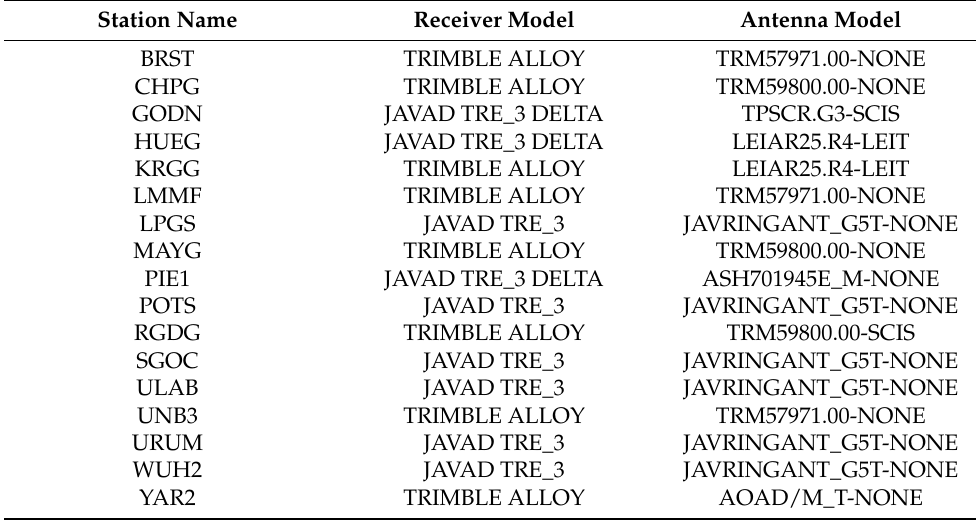
Table 4. Monitoring station receiver type and antenna type.